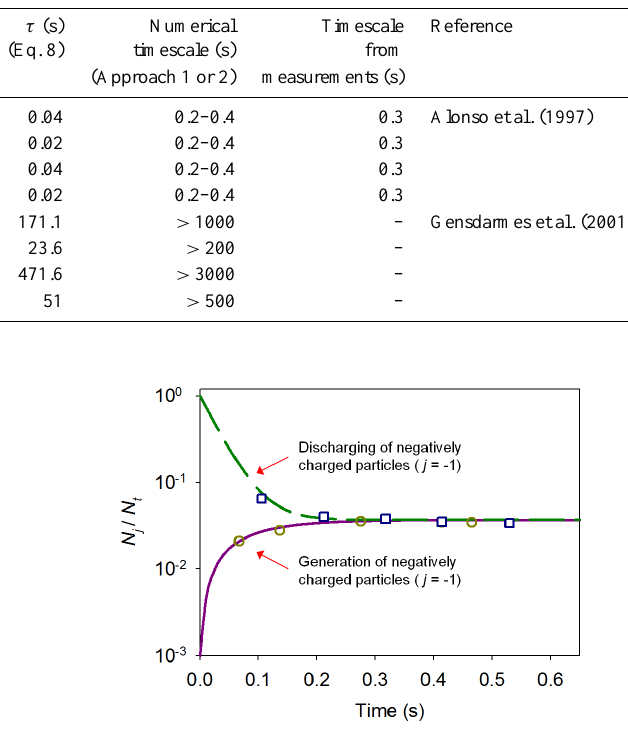
Figure 5. Timescale to reach steady-state charge accumulation rates of 0.0071µm nanoparticles. The lines are the simulation results of Approach 1. The symbols are the measurements of Alonso et al. (1997). Charging timescales were estimated using Eq. 8 ( τ charging = 0 . 042s and τ discharging = 0 . 017s), as well as Ap- proach 1 and the